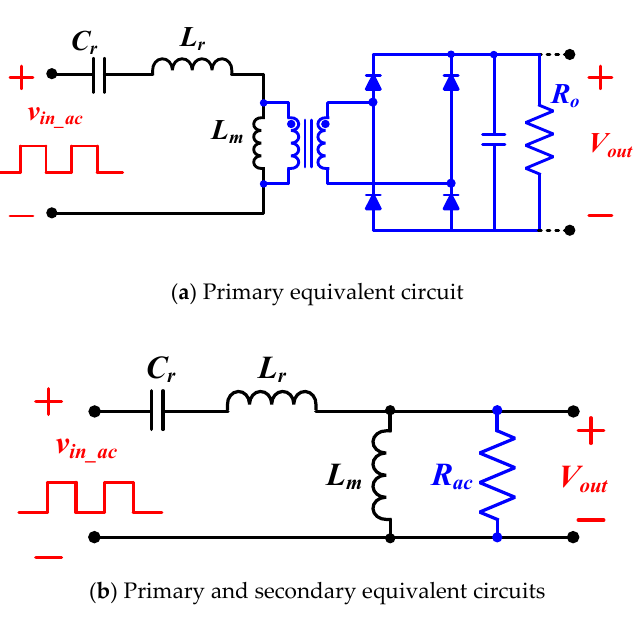
Figure 3. Equivalent circuit for Switching Pattern 1.